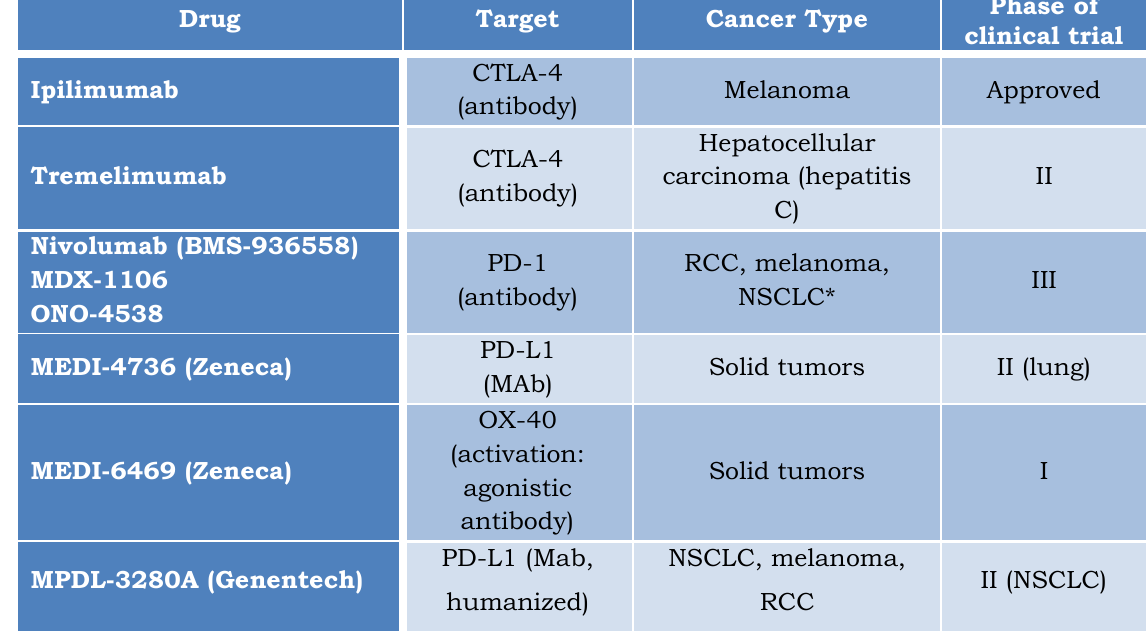
Table 2. Anti-cancer drugs targeting immune regulatory checkpoints (Revised from 3) Drug Target Cancer Type